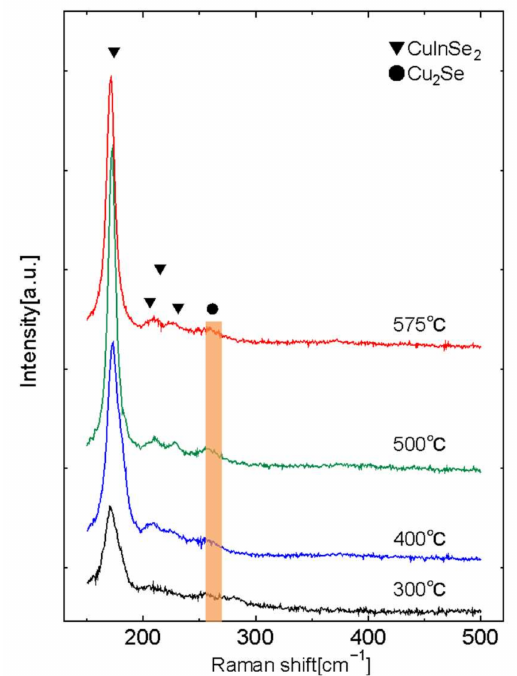
Figure 6. Results of Raman scattering measurements of the CIS films selenized at 300, 400, 500, and 575 ◦ C.